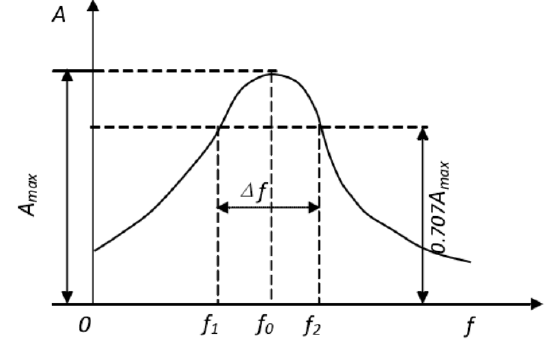
Figure 4. Estimation of the damping ratio of concrete using the half-power bandwidth method [29].